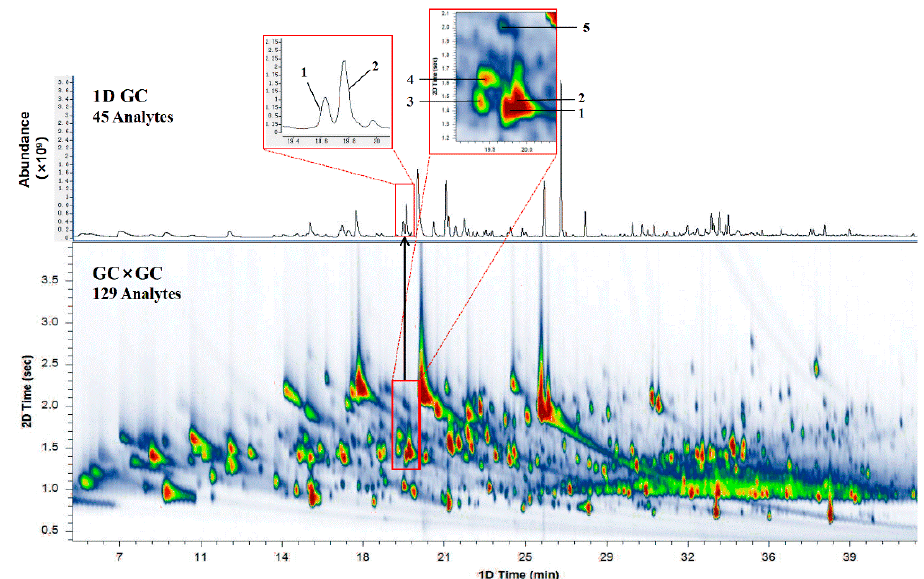
Figure 1. Chromatographic analysis of Rhododendron by GC-quadrupole time-of-flight mass spectrometry (QTOFMS) and a comprehensive two-dimensional gas chromatography–mass spectrometry (GC×GC)-QTOFMS color diagram (1: linalool; 2: 2-nonen-1-ol; 3: linalool oxide; 4: p - cymenene; 5: benzoic acid, methyl